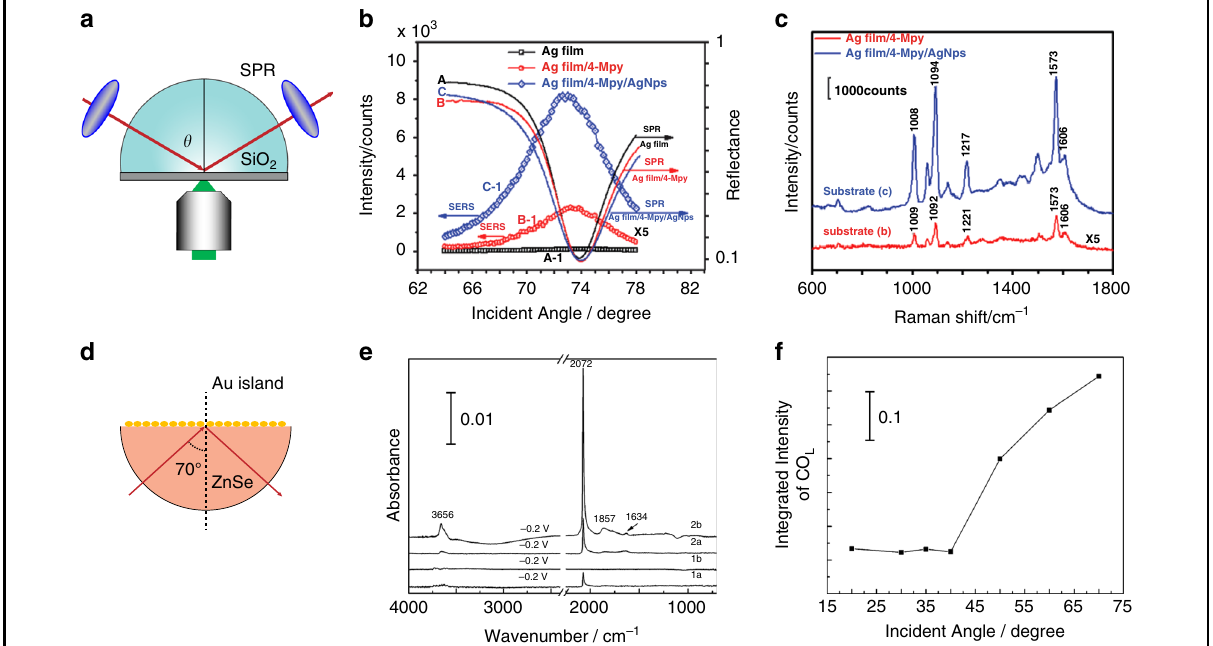
Fig. 9 ATR-SERS and ATR-SEIRA optics for LSP and SPP coupling. a Schematic diagram of a Kretschmann SPR sensor. b AOI-dependent SERS spectra on silver fi lm and nanoparticle-modi fi ed silver fi lm modi fi ed by 4-Mpy single-layer molecule. c The SERS spectra of 4-Mpy on silver fi lm and nanoparticle-modi fi ed silver fi lm at an incident angle of SPR angle 52 . Adapted a – c with permission from ref. 52 Copyright (2011) Royal Society of Chemistry. d Schematic diagram of ATR-SEIRAS con fi guration containing a ZnSe hemicylindrical prism and metal island fi lm. e ATR-SEIRA spectra of a Pt fi lm electrode in CO-saturated 0.1 M HClO 4 at − 0.2 V. Spectra 1a and 2a were recorded at the incidence angle θ = 20°, and spectra 1b and 2b at θ = 70° with ZnSe/air/Si (1a and 1b) and ZnSe/water/Si (2a and 2b) windows, respectively. f SEIRA band intensity for CO function of θ , measured with the ZnSe hemicylindrical prism 94 . Reprinted d – f with permission from ref. 101 Copyright (2008) American Chemical Society